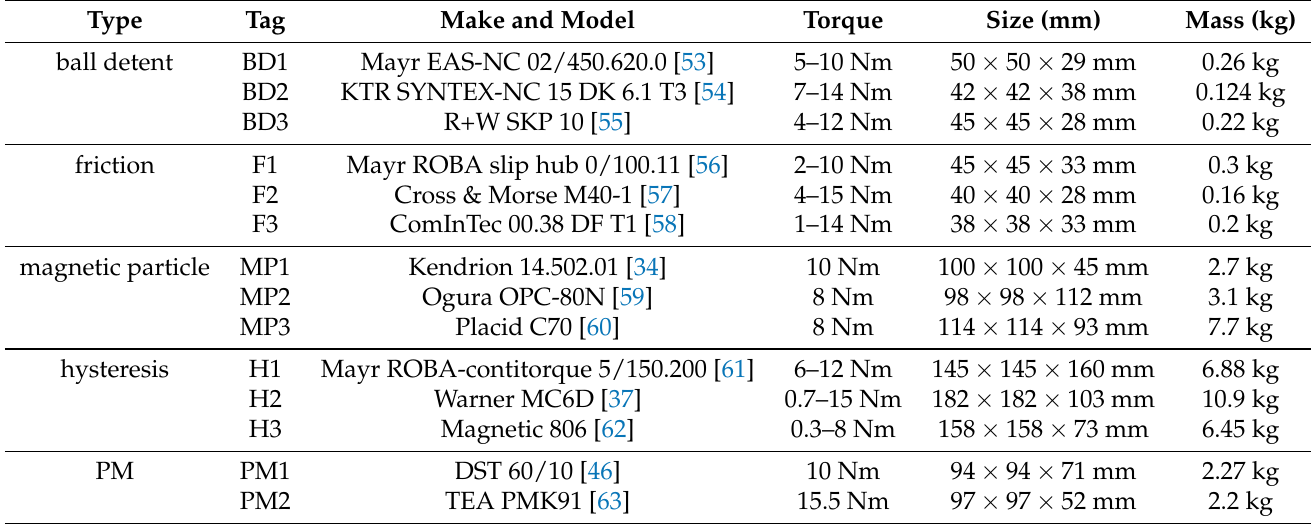
Table 1. Commerical torque limiters (10 Nm rating): envelope dimensions and